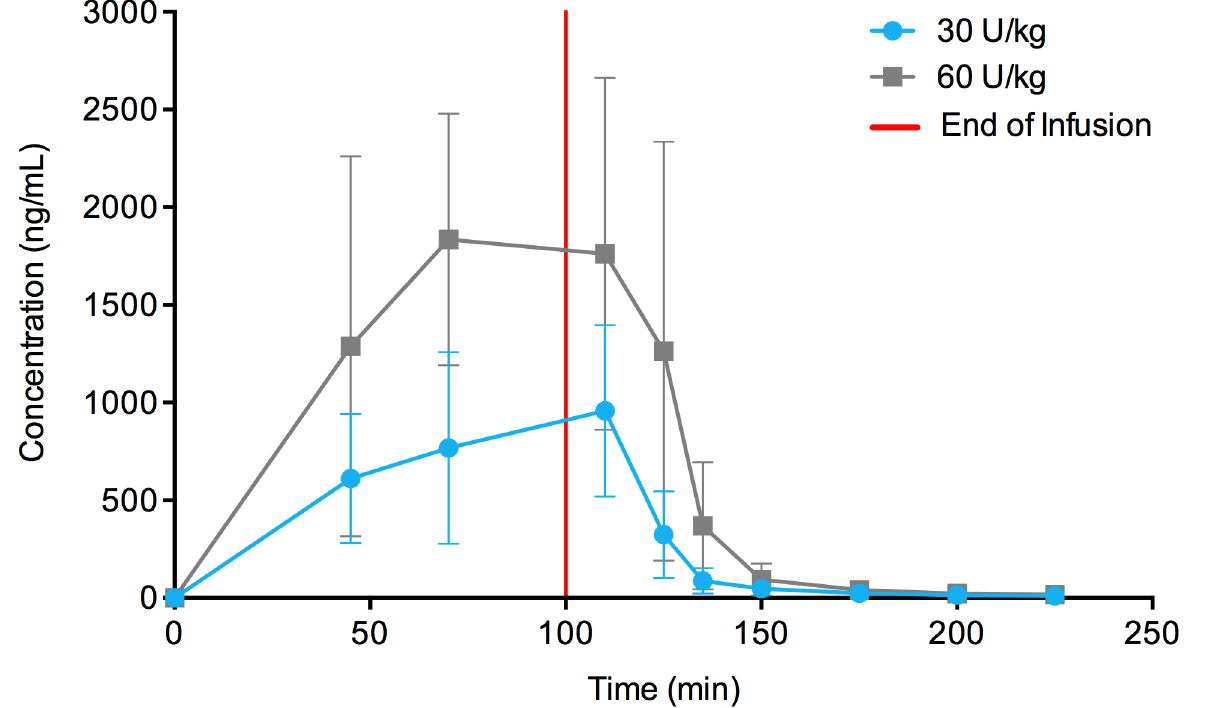
Fig 2. Taliglucerase alfa plasma concentration in pediatric patients. Mean plasma concentration-versus-time curve of taliglucerase alfa in pediatric patients for approximately 100-minute infusions showing dose-dependent increase (linear plot). Abbreviation: U/kg, Units/kg. Error bars represent standard